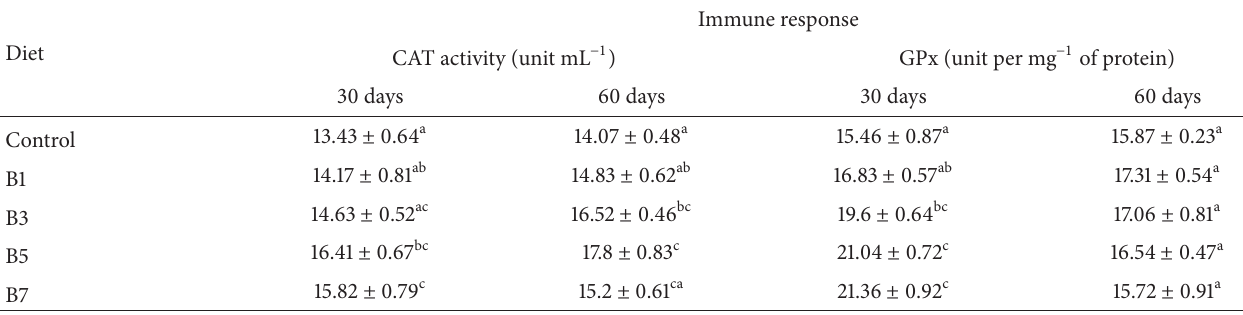
Table 7: Catalase (CAT) activity and glutathione peroxidase (GPx) level measured on different sampling days after feeding Labeo rohita with banana peel flour (BPF) supplemented diets.